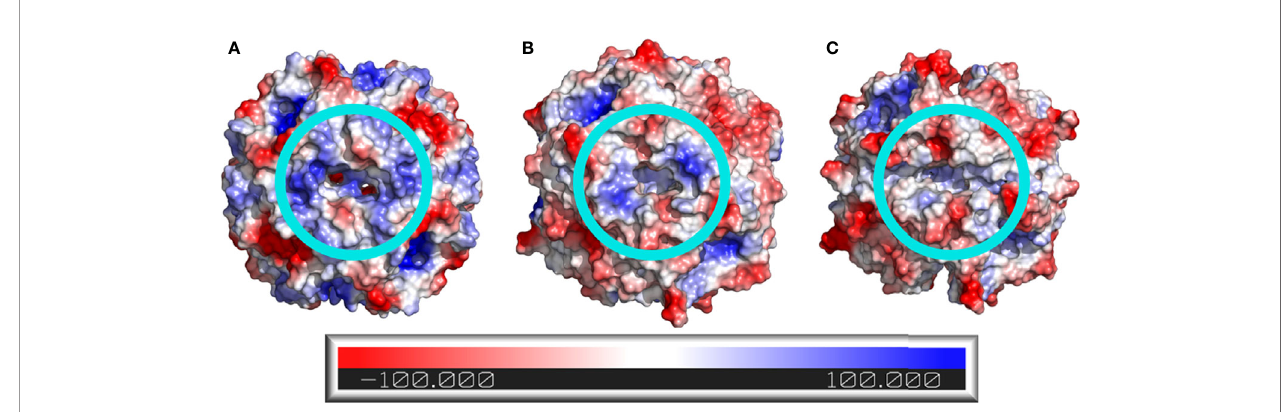
FIGURE 6 | Electrostatic potential surface of the dodecin dodecamers. The electrostatic potential surface of (A) H. h alophila , (B) M.tb , and (C) BCG Moreau dodecins is shown as a color scale in the protein surface, where positively charged regions are colored blue and negatively charged regions are colored red. The light blue circles highlight the ribo fl avin binding site.